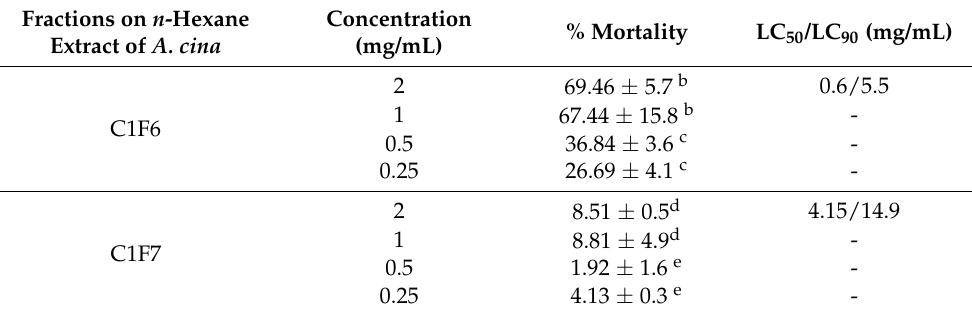
Table 2. Cont. Fractions on n -Hexane Extract of A. cina